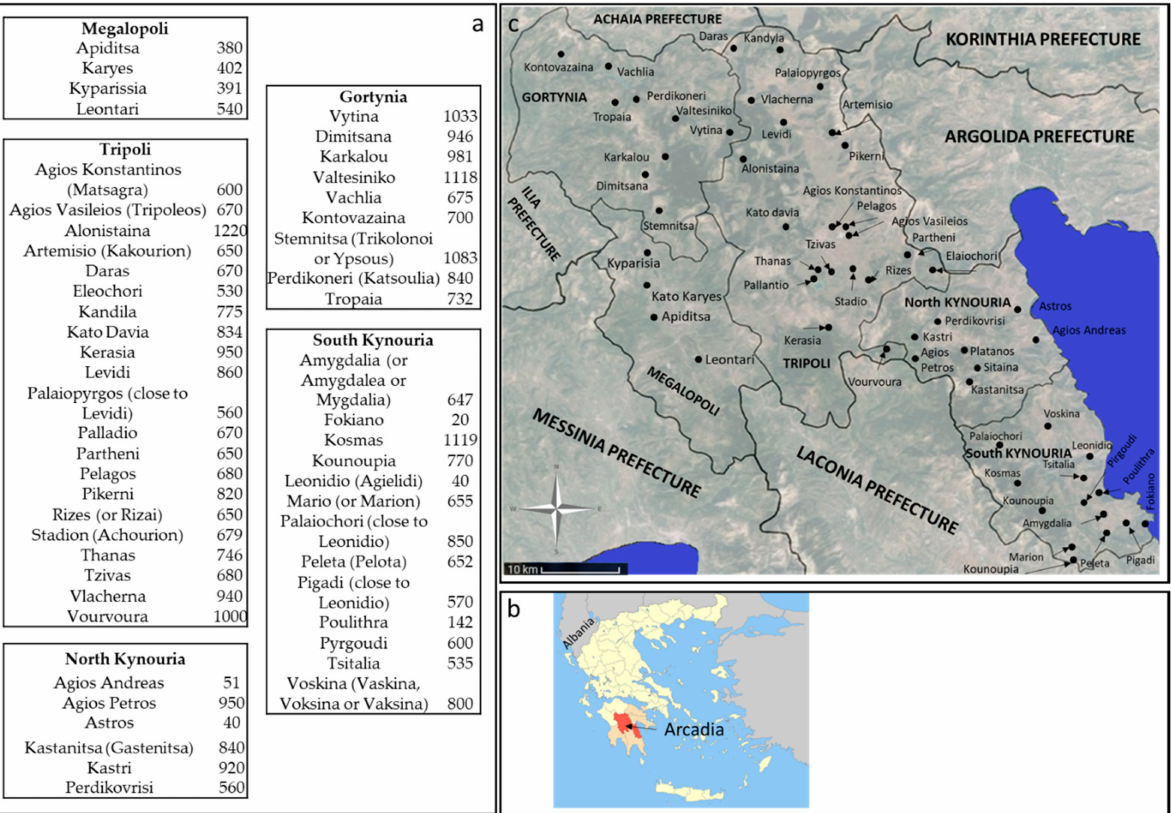
Figure 1. ( a ) Visited villages with their altitude in m (above sea level), ( b ) location of Arcadia prefecture in Greece, ( c ) visited village position in